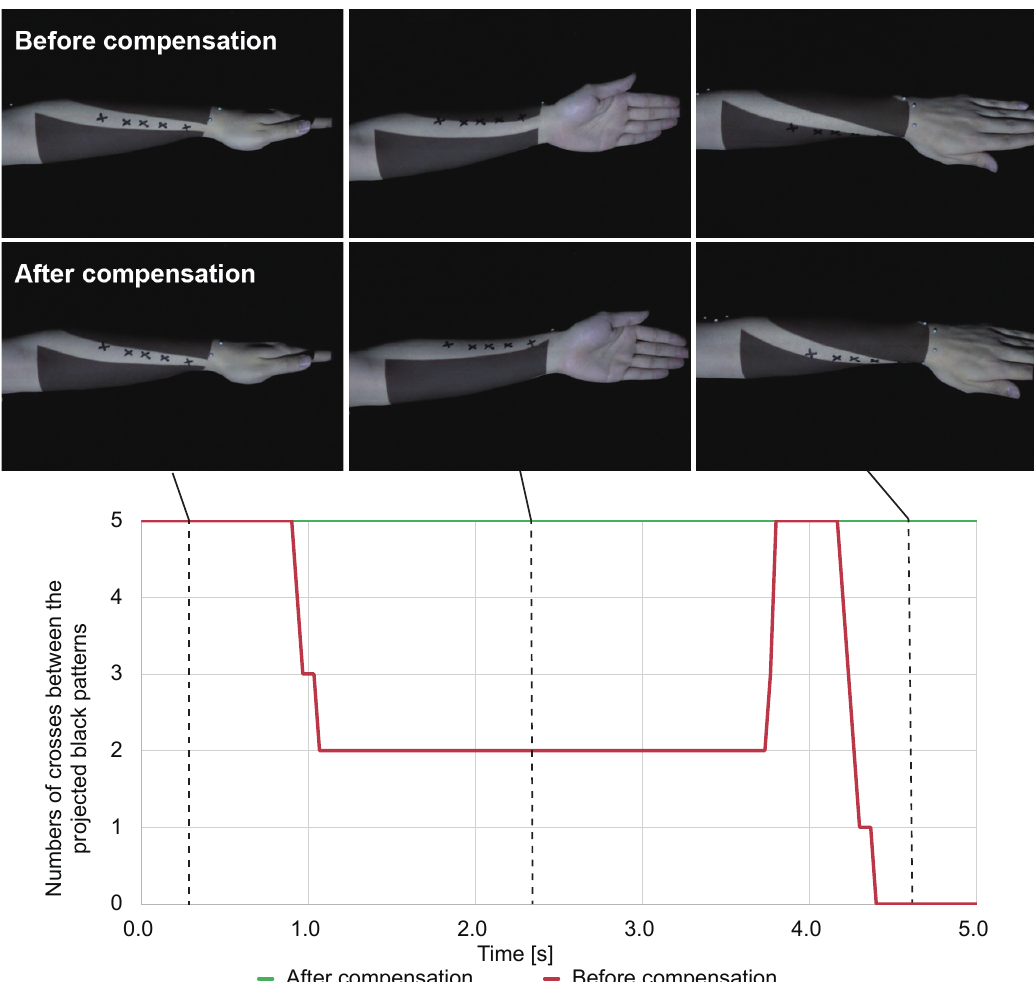
Figure 2. Photographs before (first row) and after (second row) accuracy compensation. The black patterns are projected images. The black crosses drawn on the arm using an ink marker indicate the ground truth for skin deformation. Numbers of crosses between the projected black patterns in the time sequence before and after accuracy compensation